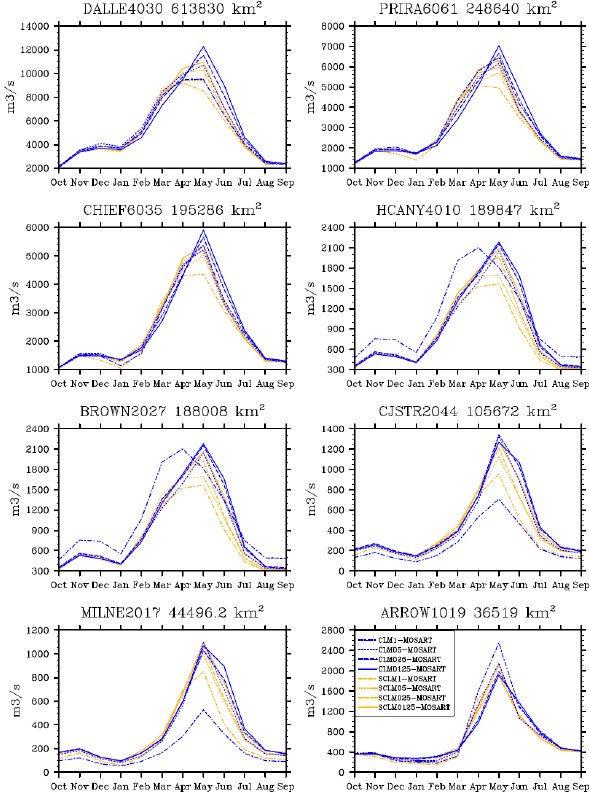
Figure 7. Streamflow from different resolution SCLM-MOSART and CLM-MOSART simulations across different spatial scales (drainage